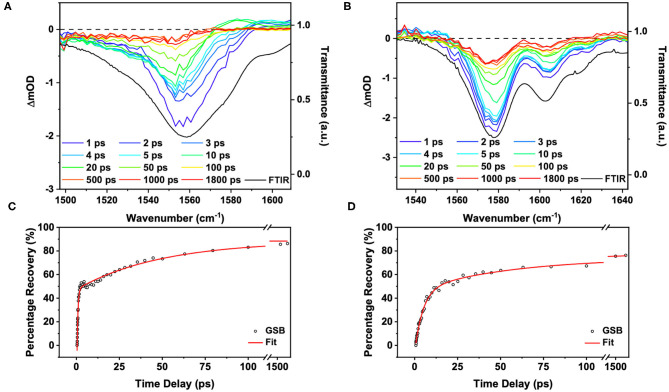
TVA spectra at selected time delays and steady-state FTIR of 50 mM ACyO in (A) EtOH photoexcited at 285 nm and (B) DMSO photoexcited at 280 nm. Scale on left of plots correspond to the change in optical density for the TVA spectra (colored lines) and scale of the right corresponds to the transmittance for the FTIR spectra (black lines). (C) Tri-exponential fit of the percentage recovery of the integrated GSB signal from the TVA spectra for ACyO in EtOH (1,540–1,550 cm−1). (D) Tri-exponential fit of the percentage recovery of the integrated GSB signal from the TVA spectra for ACyO in DMSO (1,560–1,585 cm−1). In both (C,D), the open circles are the integrated GSB signal converted to percentage recovery and the red line is the fit. The time delays are plotted linearly until 110 ps then there is a break until 1,300 ps. Between 1,300 and 1,900 ps the scale is plotted logarithmically to show that the fit does not tend to zero.